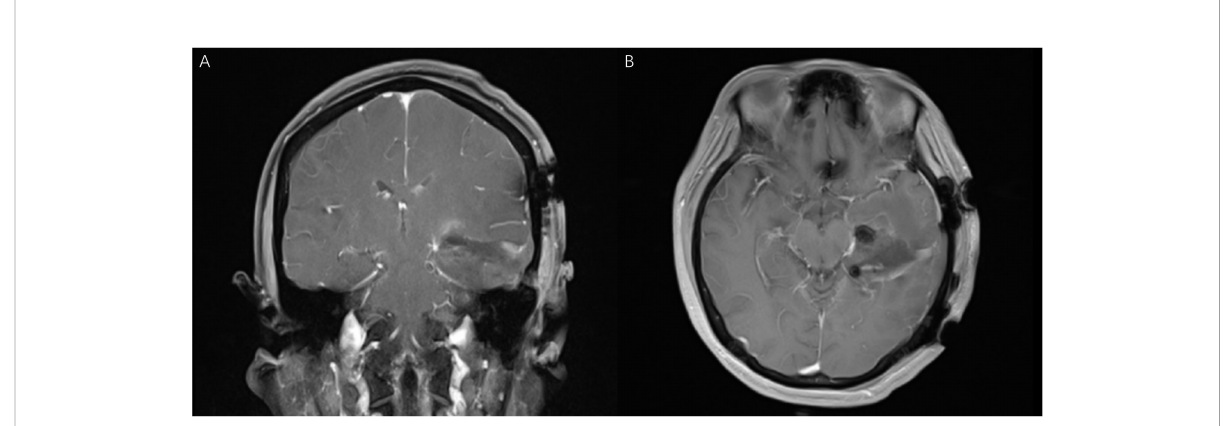
FIGURE 8 (Patient No.12) The coronal (A) and axial (B) MR T1 weighted images (one day after operation) con fi rmed the gross total resection of the tumor. The visual functions were well